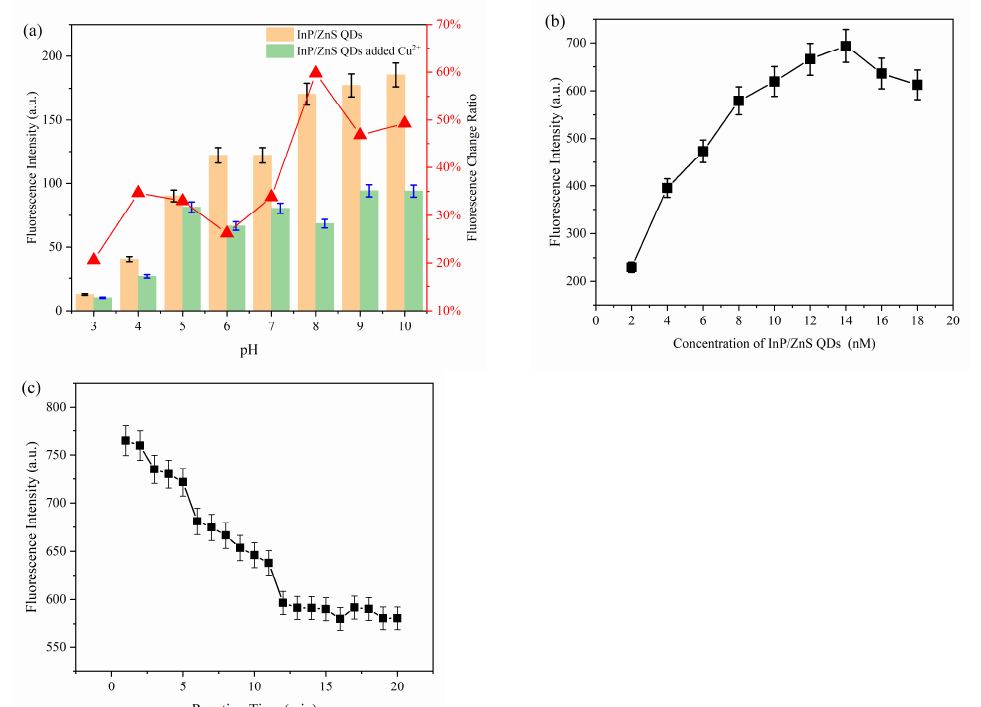
Figure 4. The fluorescence intensity of MPA-InP/ZnS QDs without and with Cu 2+ in different pH and the fluorescence-quenching rate of MPA-InP/ZnS QDs after adding Cu 2+ ( a ), the fluorescence intensity of MPA-InP/ZnS QDs in different concentrations ( b ), and the changes of fluorescence intensity of MPA-InP/ZnS QDs with added copper over time ( c ). MPA-InP/ZnS QDs: mercaptopropionic acid capped InP/ZnS quantum dots.